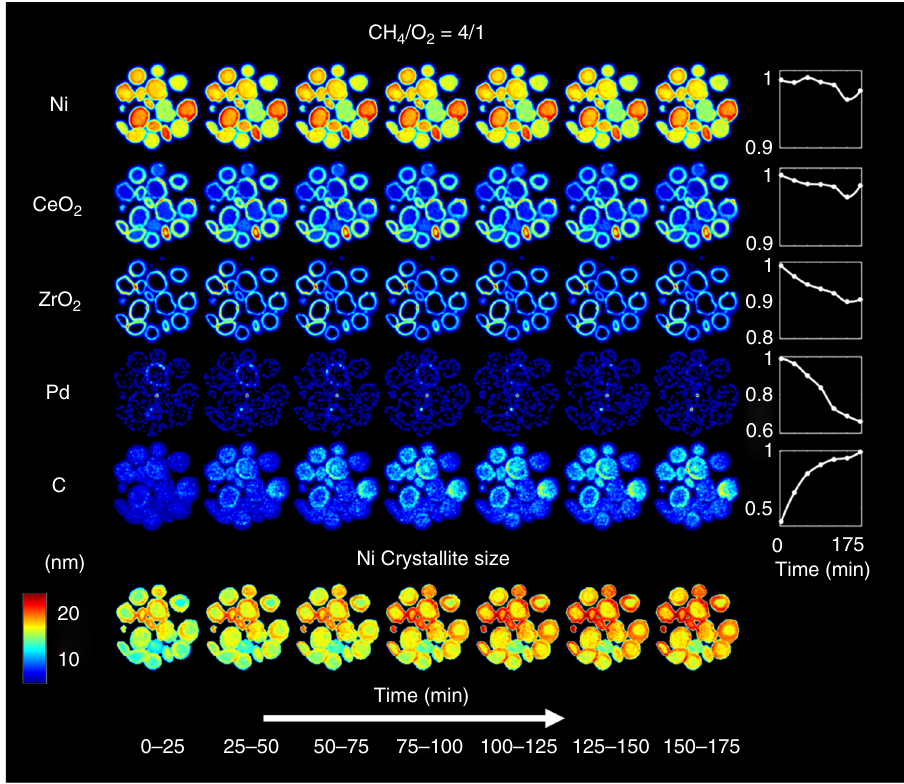
Fig. 7 Chemical evolution of the catalyst during partial oxidation of methane. Phase distribution maps of Ni, CeO 2 , ZrO 2 , Pd and C (graphite) corresponding to the normalised scale factors of these phases derived from the Rietveld analysis of the XRD-CT data collected during the POX experiment. Bottom: maps of crystallite sizes of Ni under POX reaction conditions (colour bar axes in nm). Scale bar corresponds to 1